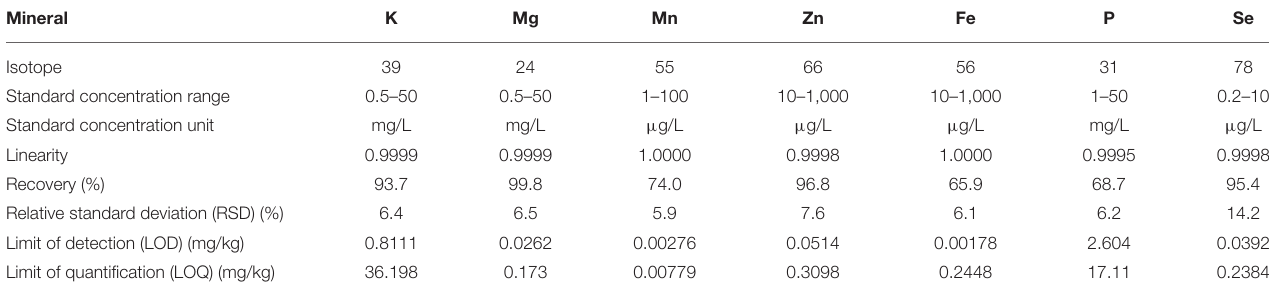
TABLE 2 | Detection and quantification parameters of maize minerals by inductively coupled plasma mass spectroscopy (ICP-MS). Mineral K Mg Mn Zn